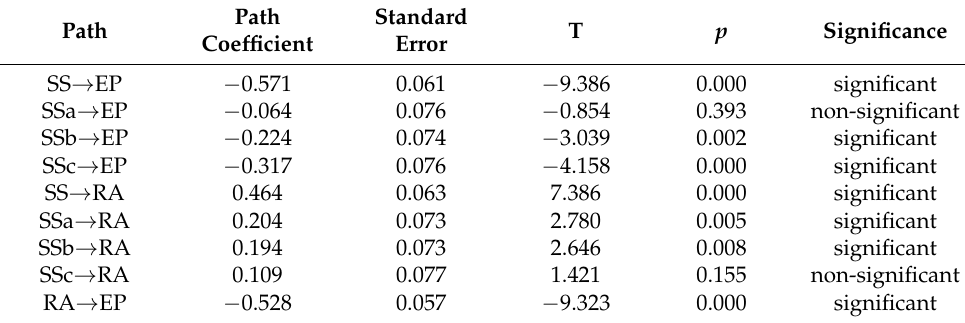
Table 3. Normalized path coefficients and significance.